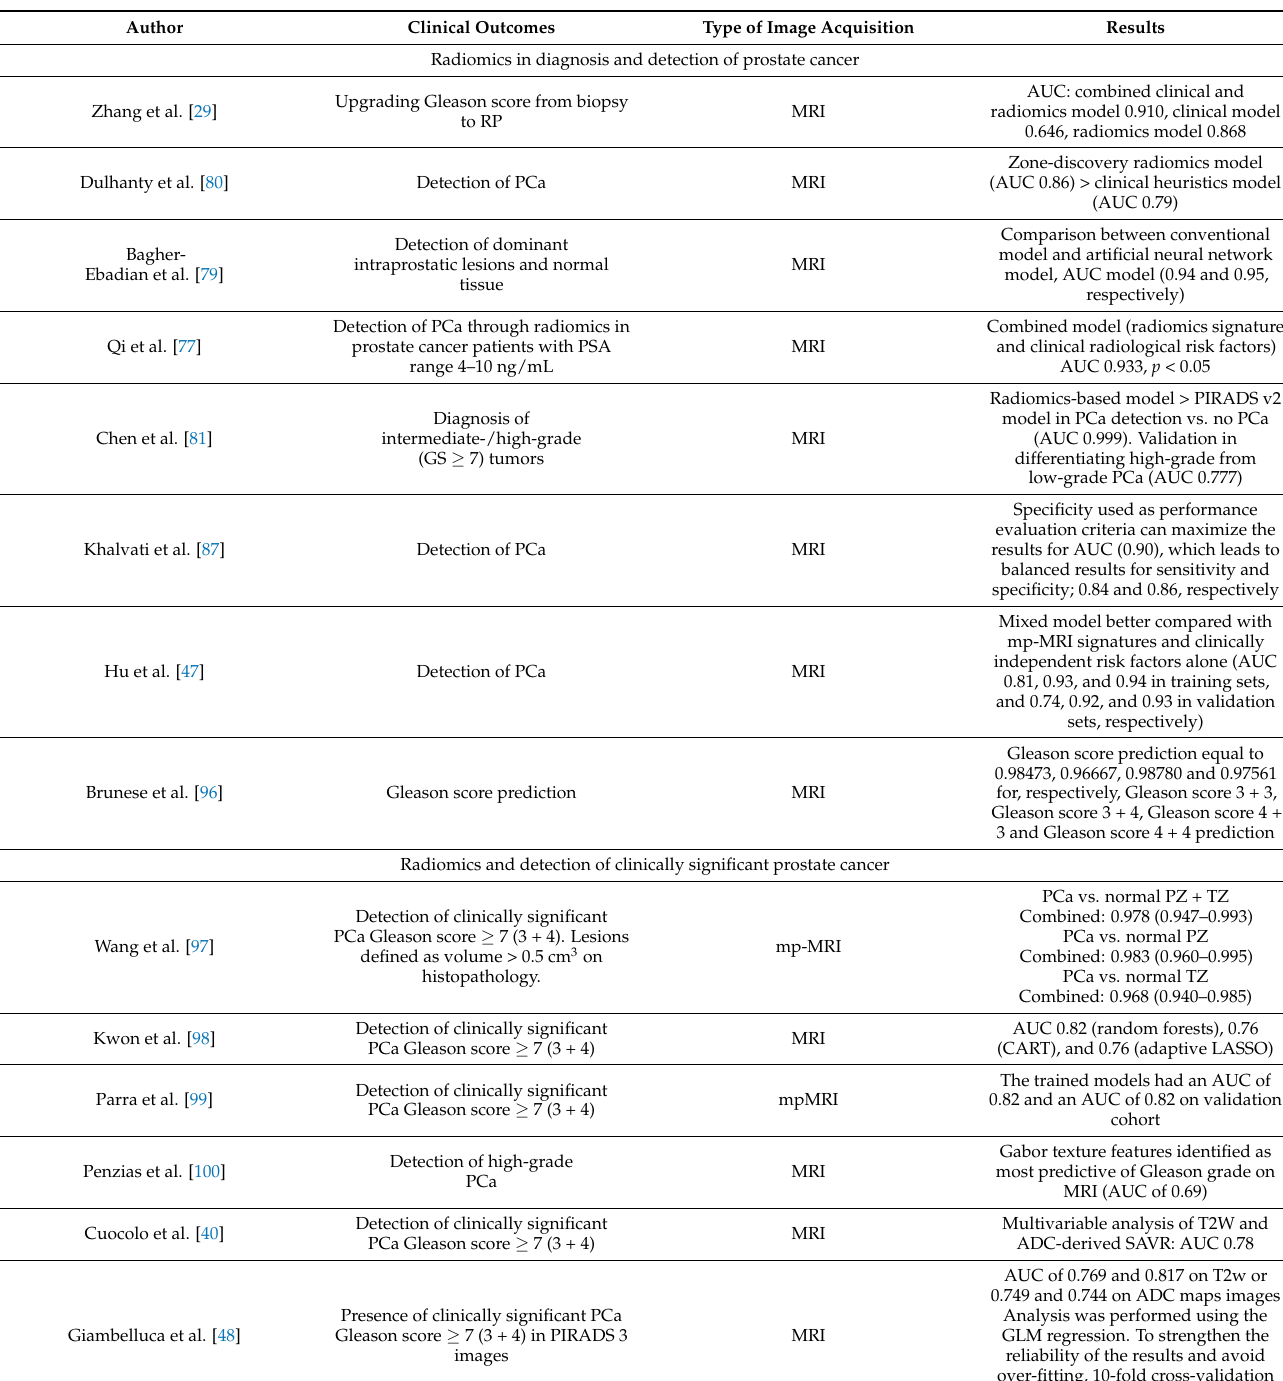
Table 2. Clinical results of radiomics